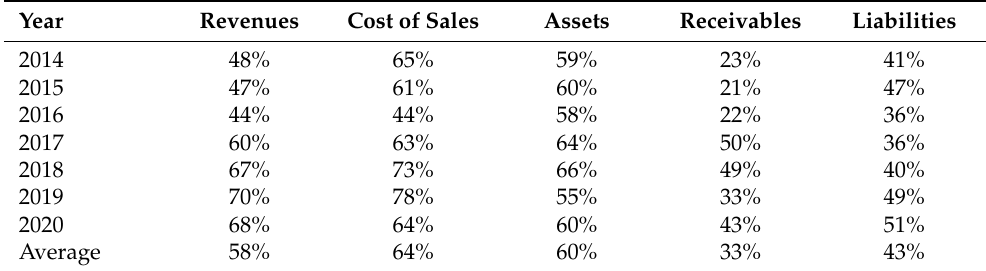
Table 3. Percentage share of conventional power generation and renewable power generation by line item in PGE’s consolidated financial statements from 2014 to